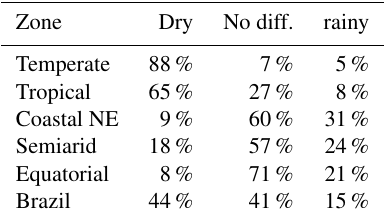
Table 7. Frequency of higher atmospheric pressure during dry and rainy days.